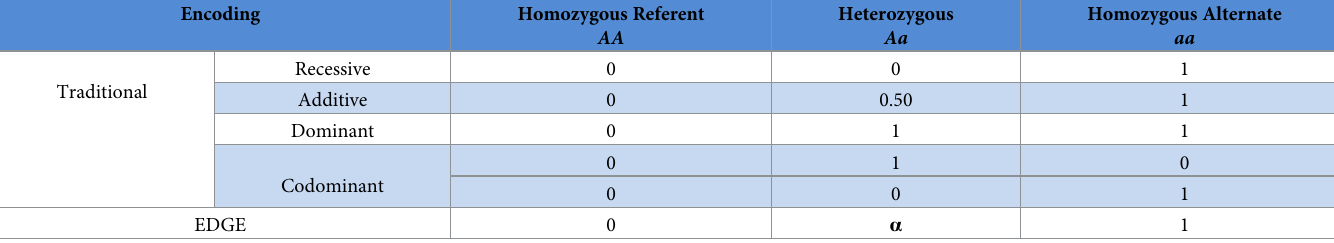
Table 2. Recessive, additive, dominant, codominant and EDGE encoding schemes, scaled between 0 and 1.